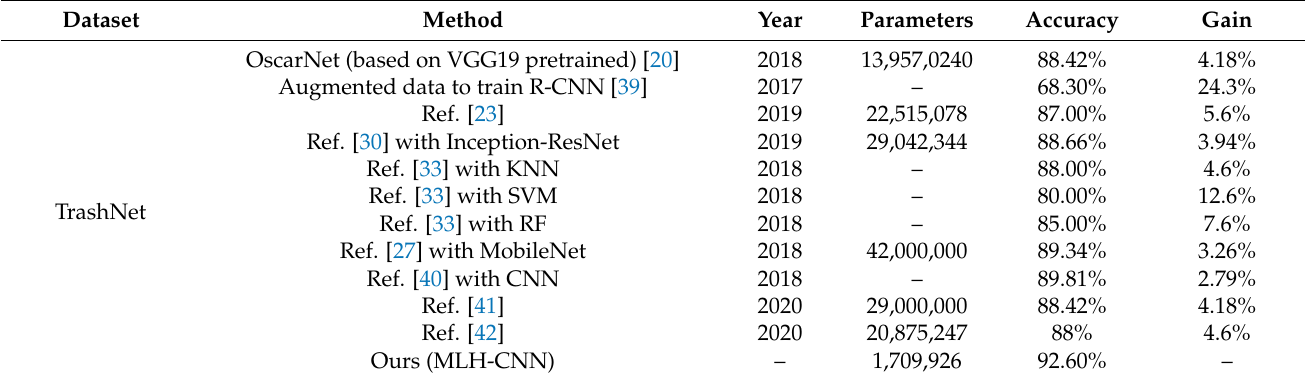
Table 6. Comparison of the results of the proposed method and other classification methods.